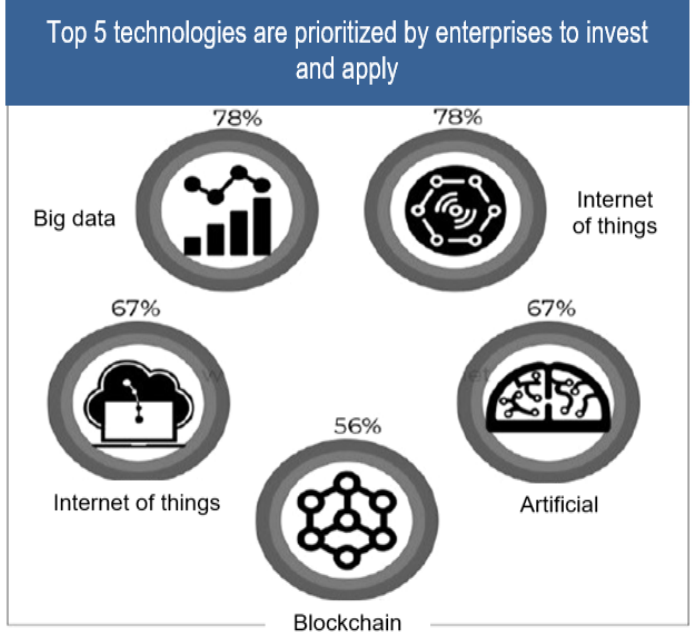
Figure 6. Top 5 technologies that enterprises are prioritizing to invest and apply